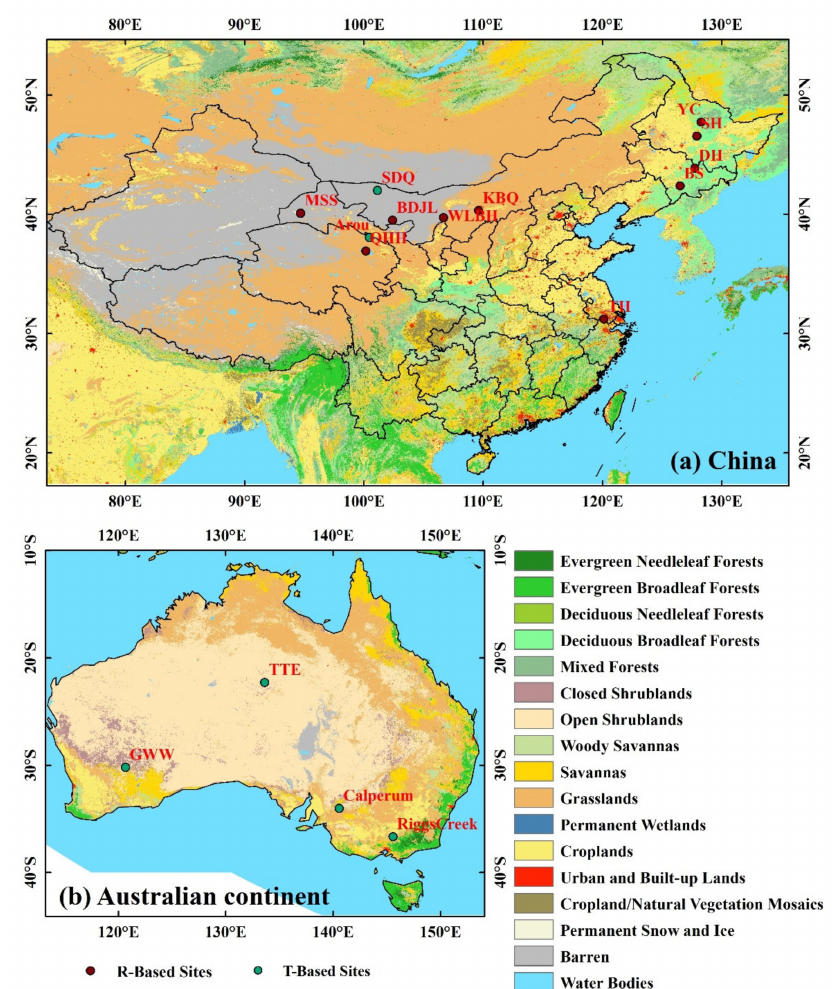
Figure 3. The geographic locations of the sites used in T-based and R-based validation (R-based sites: YC, SH, BS, DH, MSS, WLBH, BDJL, KBQ, QHH, TH. T-Based Sites: Arou, SDQ, GWW, Riggs Creek, Calperum, TTE), the background map is the Moderate Resolution Imaging Spectroradiometer (MODIS) MCD12Q1